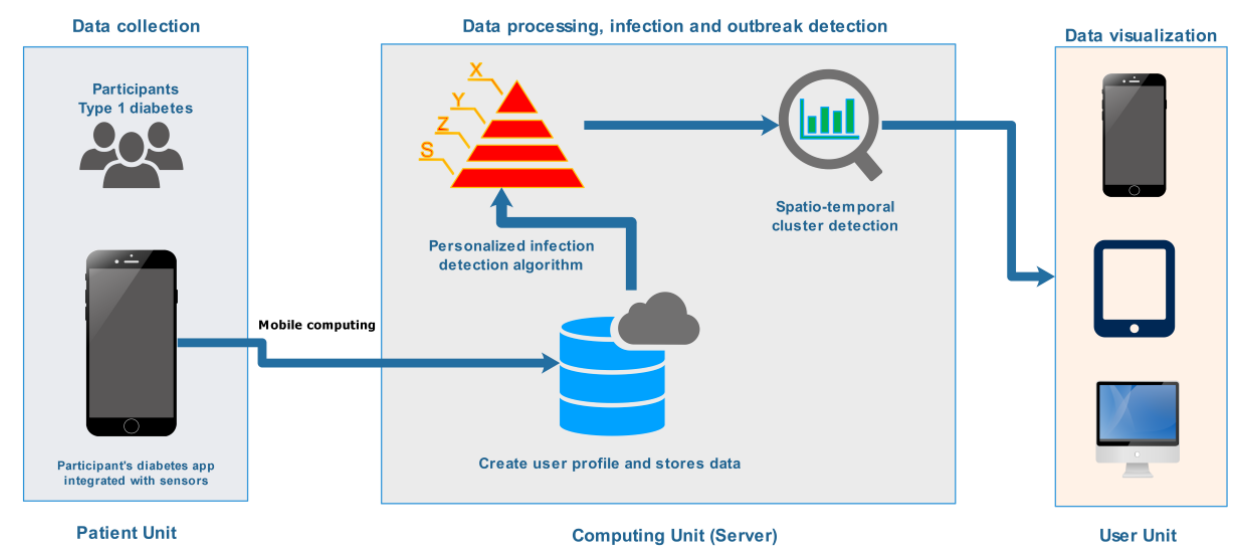
Figure 14. The Proposed System